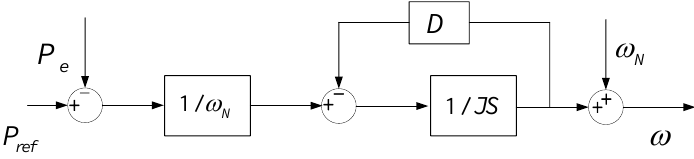
Figure 5. Frequency control block diagram.